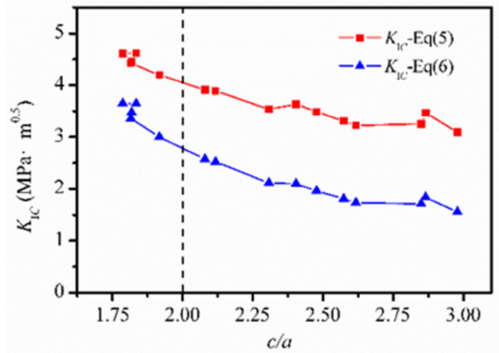
Figure 9. Relationship between c / a and K IC .